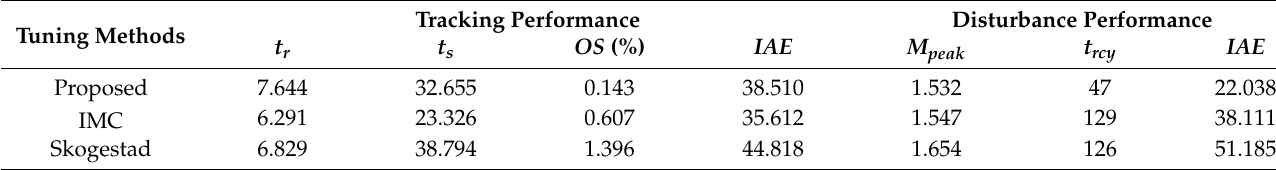
Figure 7. Step responses and steam flow rate for uncertain heat exchanger. ( a ) Step responses; ( b ) steam flow rate. Table 4. Comparison of performances for uncertain heat exchanger.